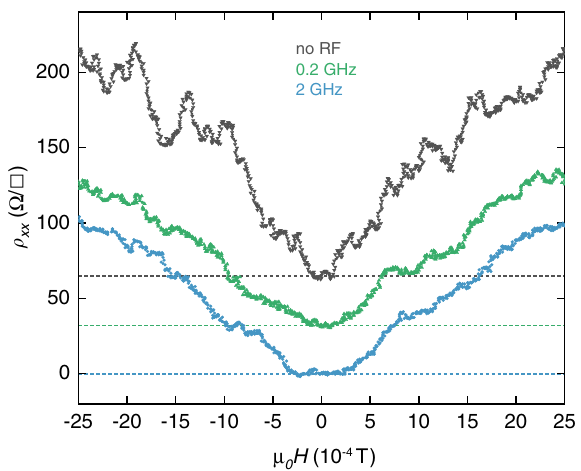
Fig. 7 Magnetoresistance of S2G subject to RF signal injection at various frequencies. Resistivity as a function of magnetic fi eld for S2G at 60 mK. RF signal of various frequencies is injected into the sample. From top to down: no RF, 0.2 GHz, and 2 GHz. ρ = 0 baseline (dashed line) of each curve is shifted for